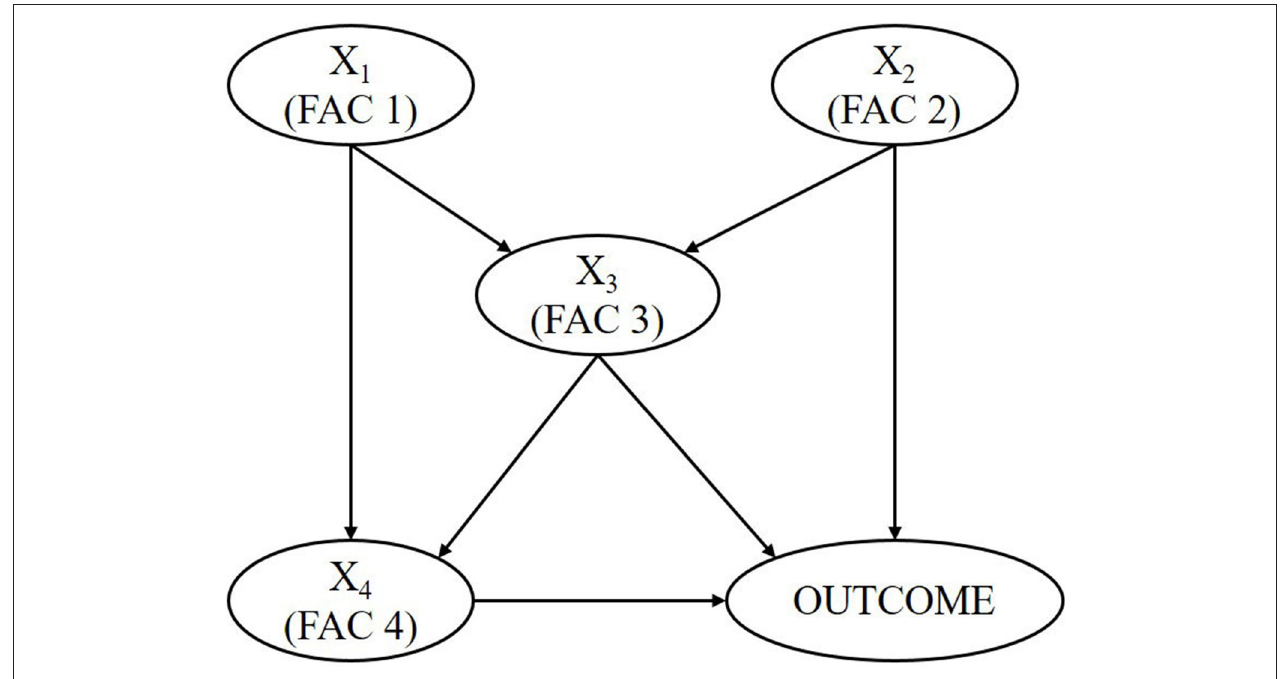
FIGURE 1 | Example of a structural causal